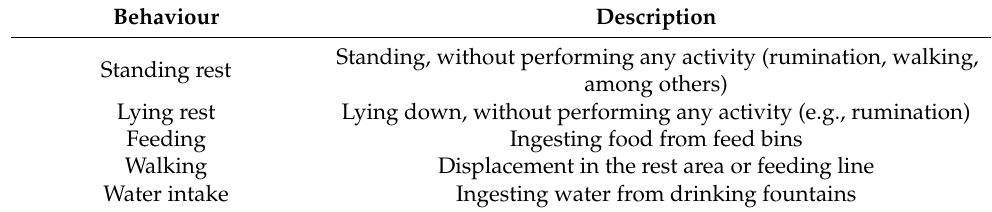
Table 2. Behavioural ethogram for dairy